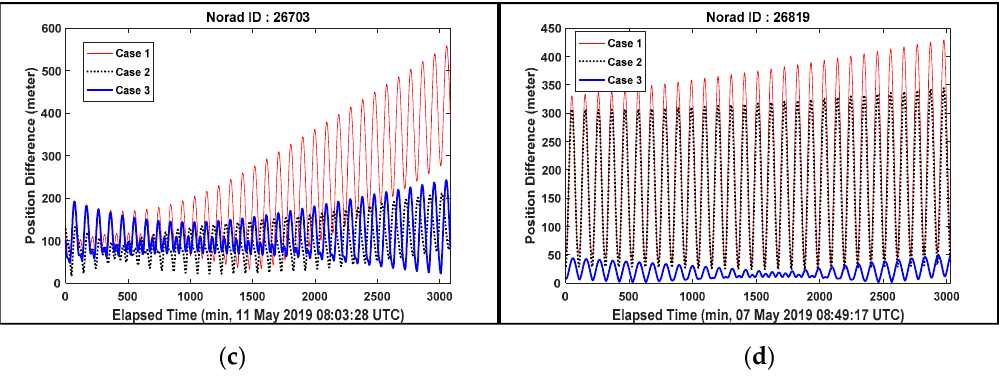
Figure 6 . Position difference results of Case 1, 2 and 3. ( a ) ID 4954; ( b ) ID 6276; ( c ) ID 26703; ( d ) ID 26819.